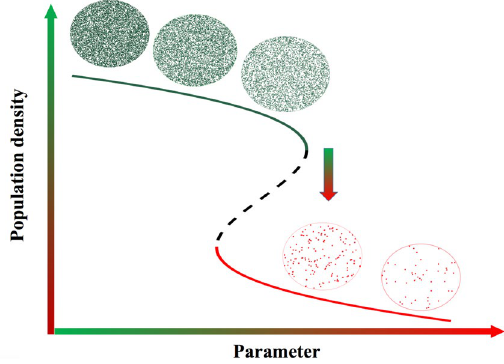
Figure 1. Schematic of a natural population subject to a critical transition. The state of the system changes abruptly from one equilibrium to another due to a slow change in the parameter.